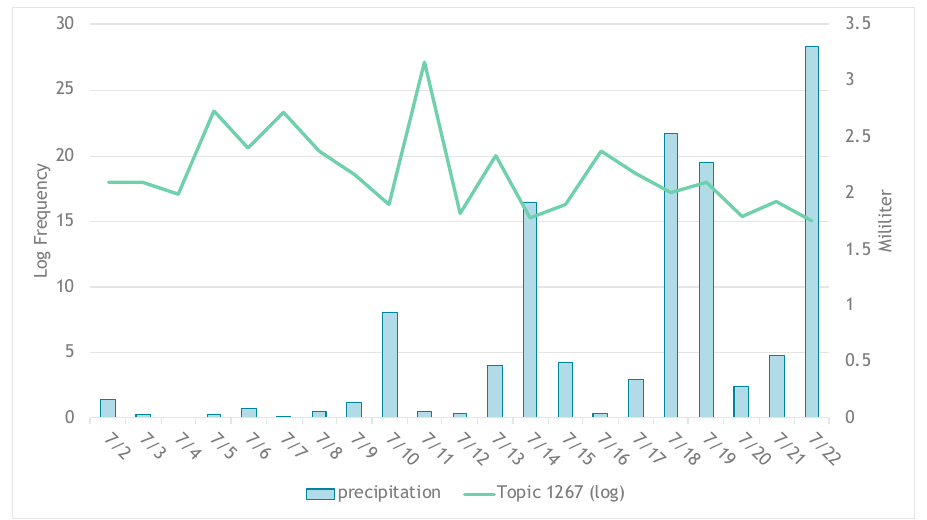
Figure 4. Precipitation and log frequency of tweets under topics 1, 2, 6, or 7 * . * Note: topics refer to the following: 1 (“ Lake save future ”), 2 (“ Conserve government waste ”), 6 (“ Pond rainwater nature ”), and 7 (“ Tap world important ”).